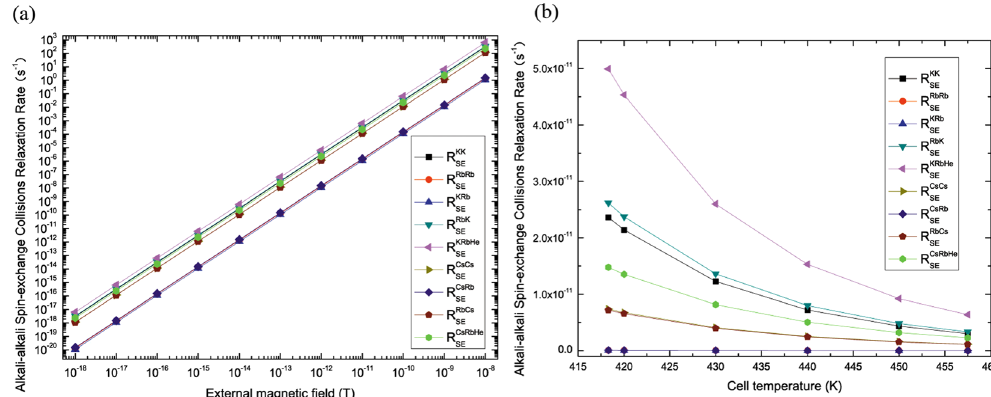
Figure 6. The alkali-alkali spin-exchange collisions relaxation rate of 39 K ( 133 Cs)- 85 Rb- 4 He magnetometers varies with the external magnetic field and cell temperature.